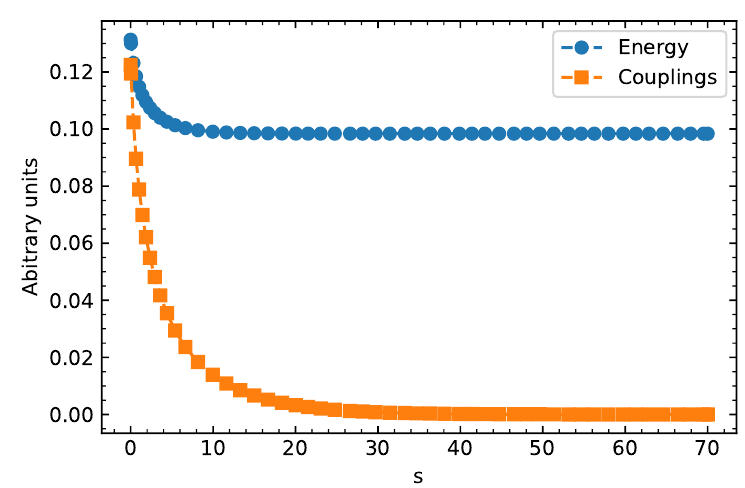
Figure 13: Illustration of a solution of the flow equations (47), (48), (49) as a func- tion of s . The ground-state energy ε N is shown using (blue) dots. The sum of the (cid:80) | f | + (cid:80) | Γ | , is presented as (orange) squares. The dashed curves couplings, i 0 ij 00 i ij are added to guide the